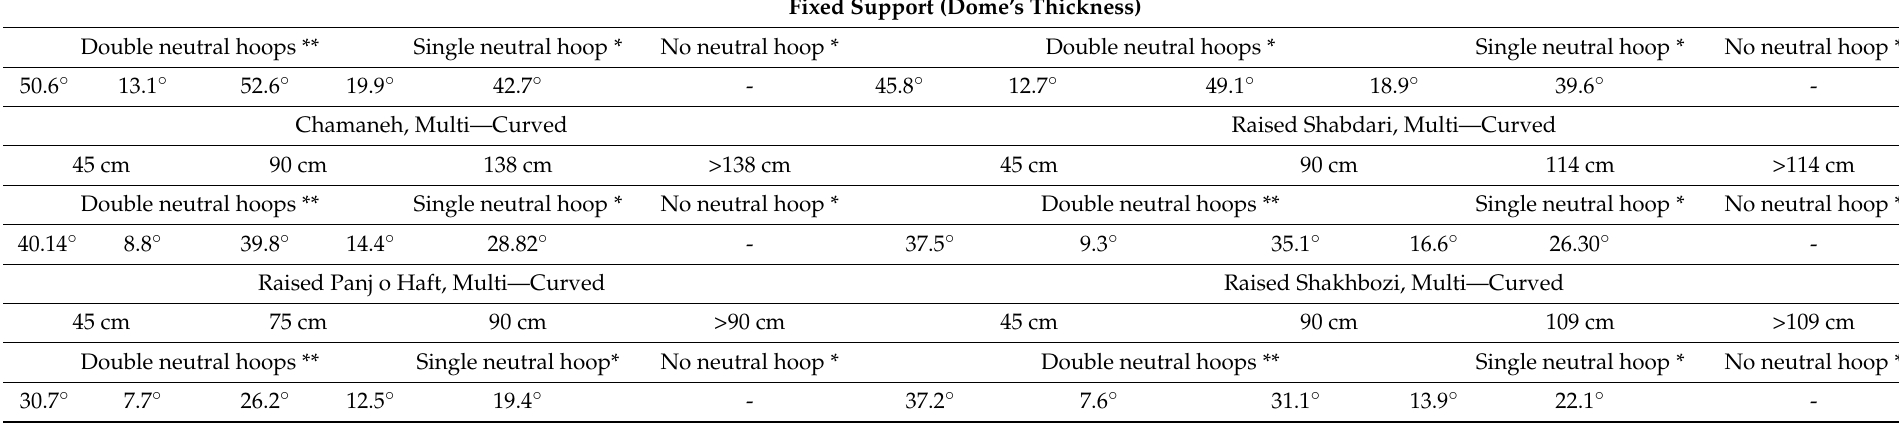
* All hoops are in compression. ** Hoops are in compression and tension. Table 6. Analysis of domes with free support in X- and Y-axes—R m = 5 m, t dome = 90 cm, t dome /d m = 0.09. Free Support in X- and Y-Axes Graphical p.s σ